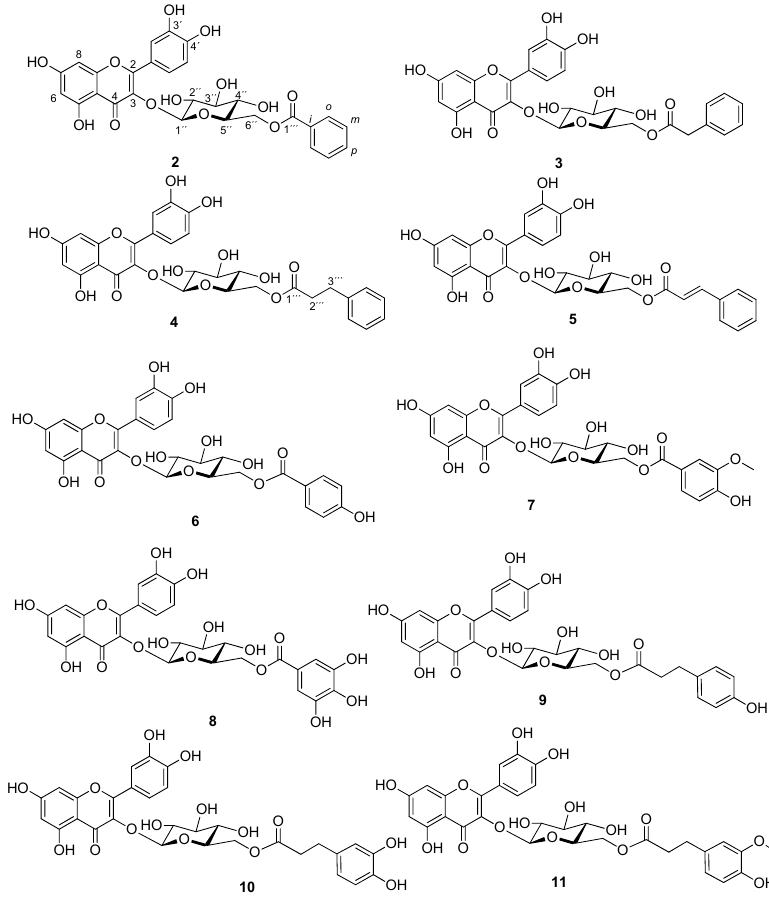
Figure 4. Proposed structures of the isoquercitrin esters 2 – 11 .